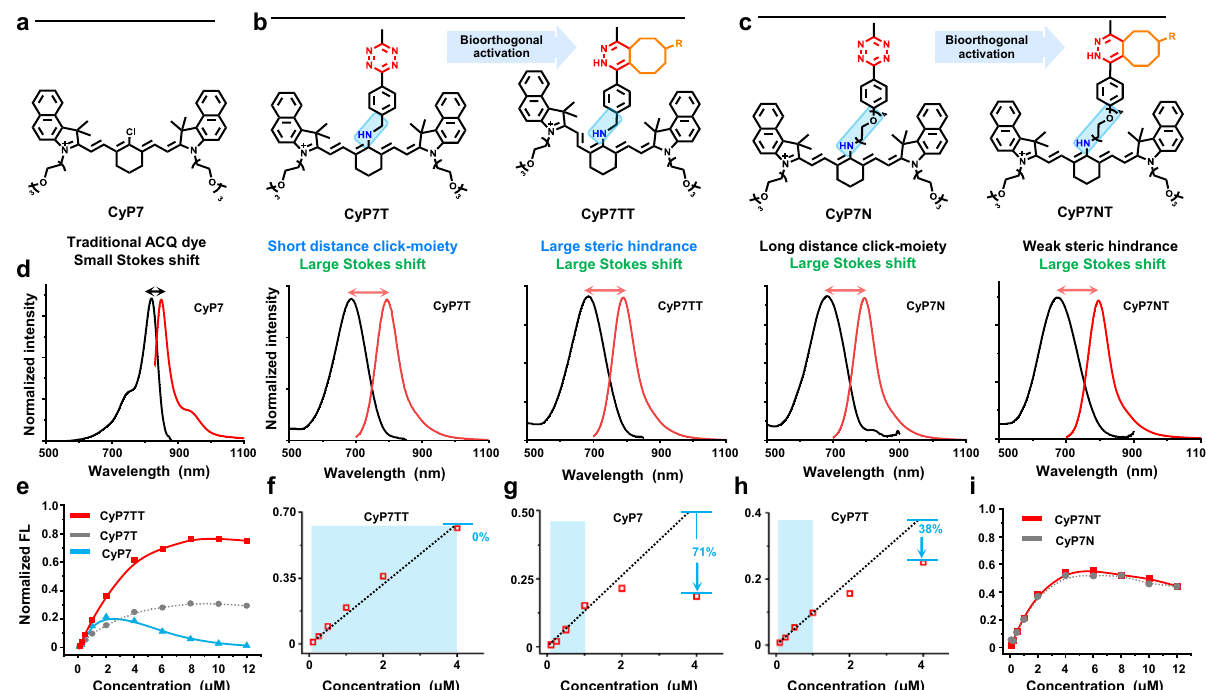
Fig. 2 Molecular design and spectra properties of cyanines. Chemical structures of a CyP7, b bioorthogonal-activated cyanines, and c control cyanines. Bioorthogonal-moiety Tz (red color group) with methyl (shorter) (CyP7T) or PEG3 (longer) (CyP7N) distances from substrate structures. CyP7TT/ CyP7NT activated by CyP7T/CyP7N and TCO via IEDDA reaction. d Normalized absorption (black)/emission (red) spectra of dyes. e Fluorescence intensity at the maximum emission spectra with different concentrations of cyanines. f – h Fluorescence loss with concentrations. Dotted lines represent ideal linear relationship between fl uorescence intensity and concentration, indicating non-quenching in blue range. i ACQ effect for control group (CyP7NT formed by CyP7N and